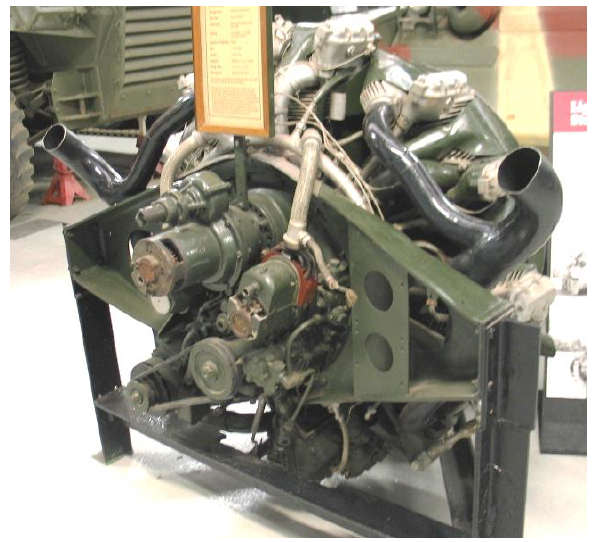
Fig. 6. The Continental W670-9A engine (The Tank Museum at Bovington Camp in Dorset, photo by the author) Fig. 7. Wright R-975 engine (The Tank Museum at Bovington Camp in